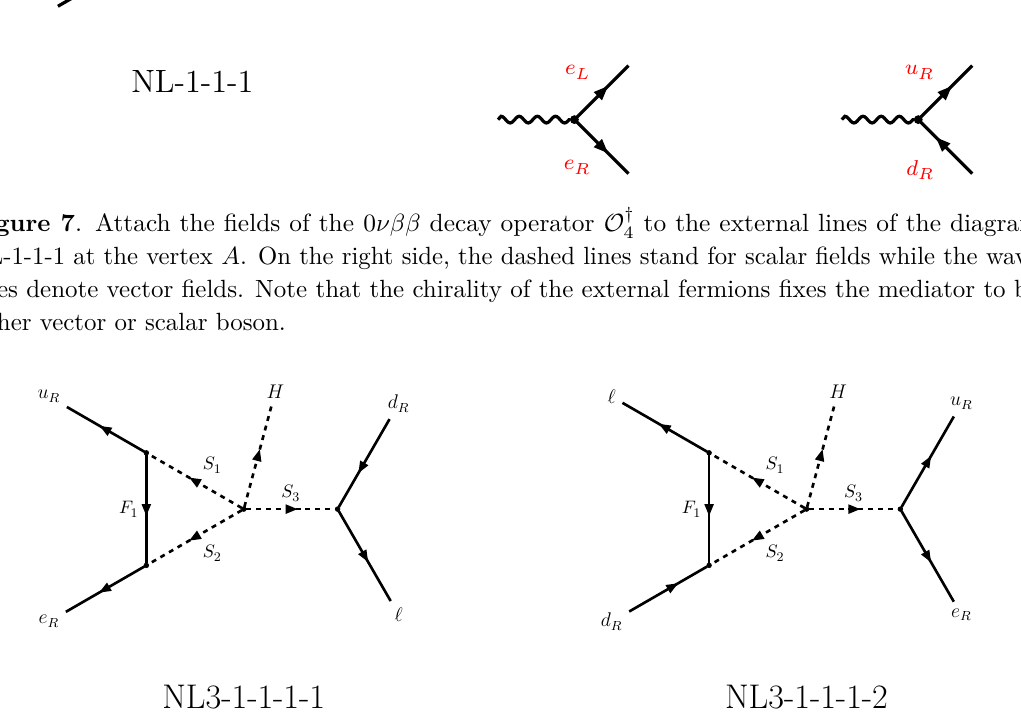
Figure 8 . Attach external fields of NL3 to the diagram NL-1-1-1. After attaching external fields, we change the notation “NL-” to corresponding operator notation